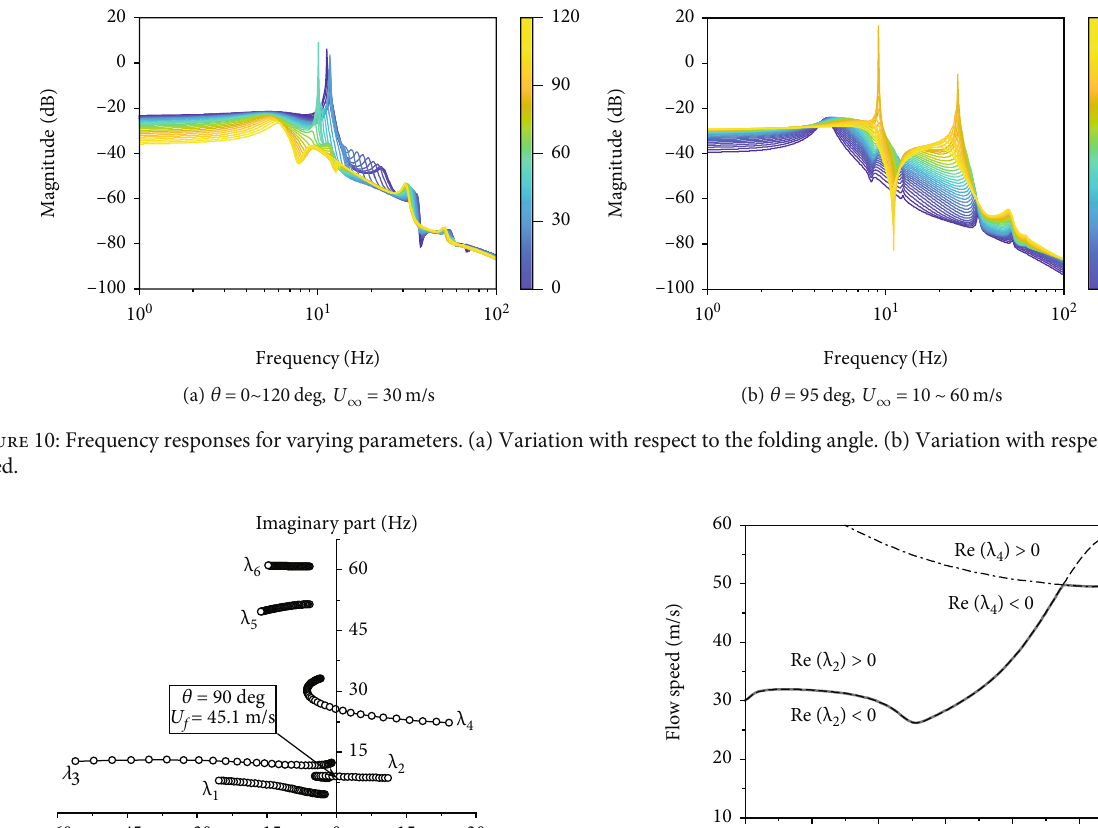
Figure 9: Comparison of frequency responses of the exact model (solid black, θ = 65 deg, U incoherent (dashed red) and coherent (dashed green) system